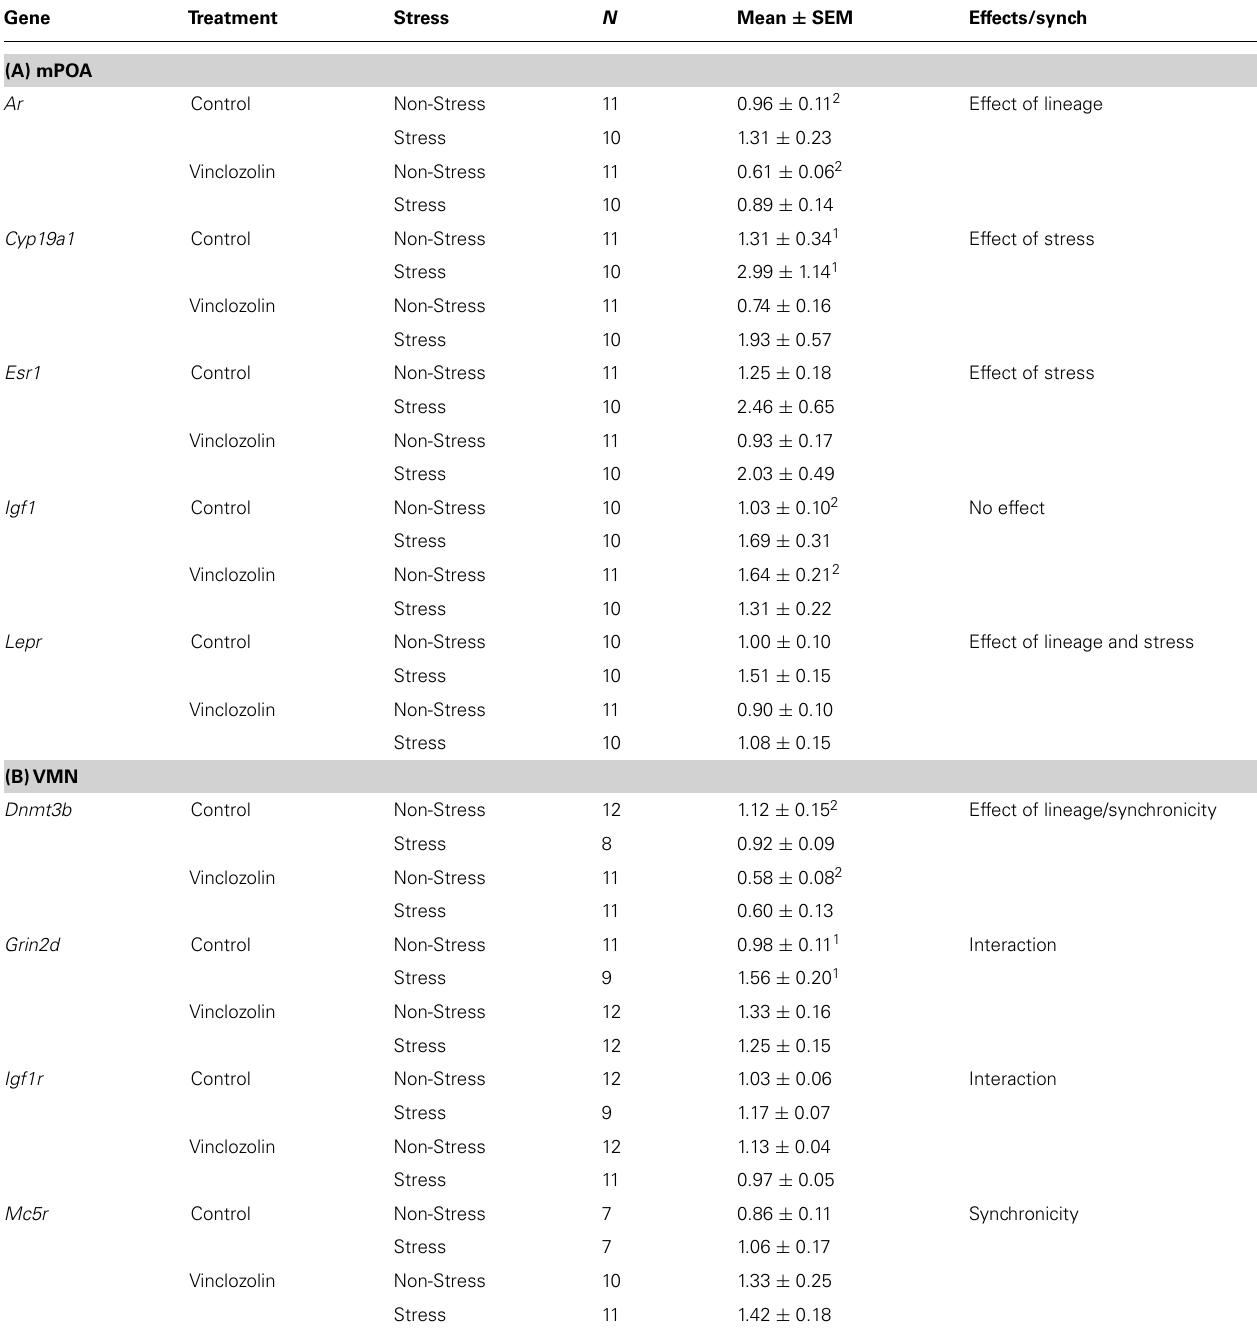
Table 3 | Hypothalamus data